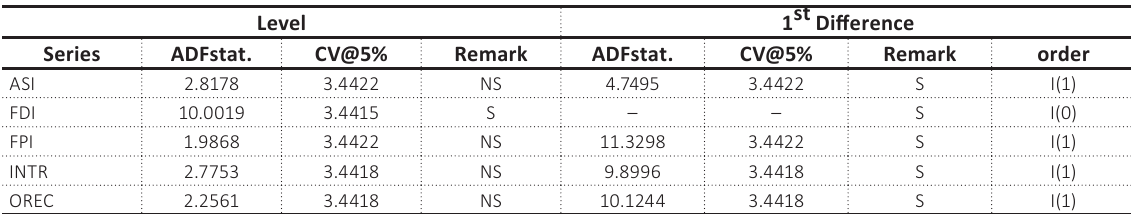
Table 3. Test for stationarity at the level and after the 1 st